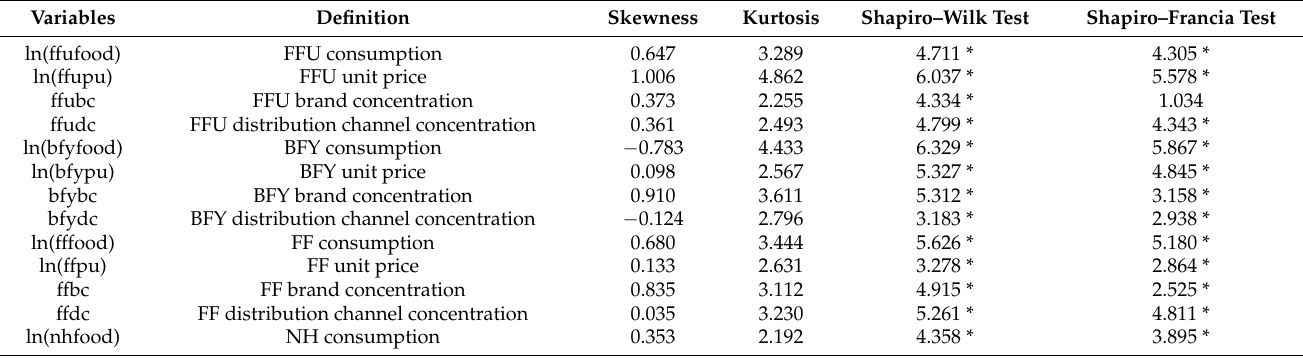
Table A2. Test results of normality for alternative